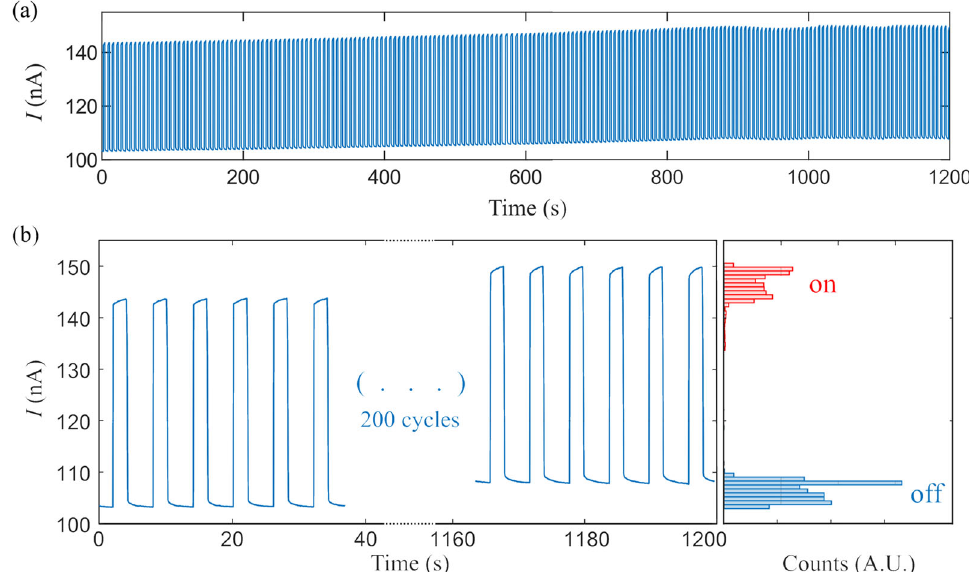
Fig. 5 Stability of the WS 2 devices. a I – t measurement cycles in the WS 2 device while alternatively switching the illumination on and off during a 20-min period. b Zoom-in of the initial and fi nal sections of a . The right panel in b shows a histogram of the measured current I over the complete 20-min